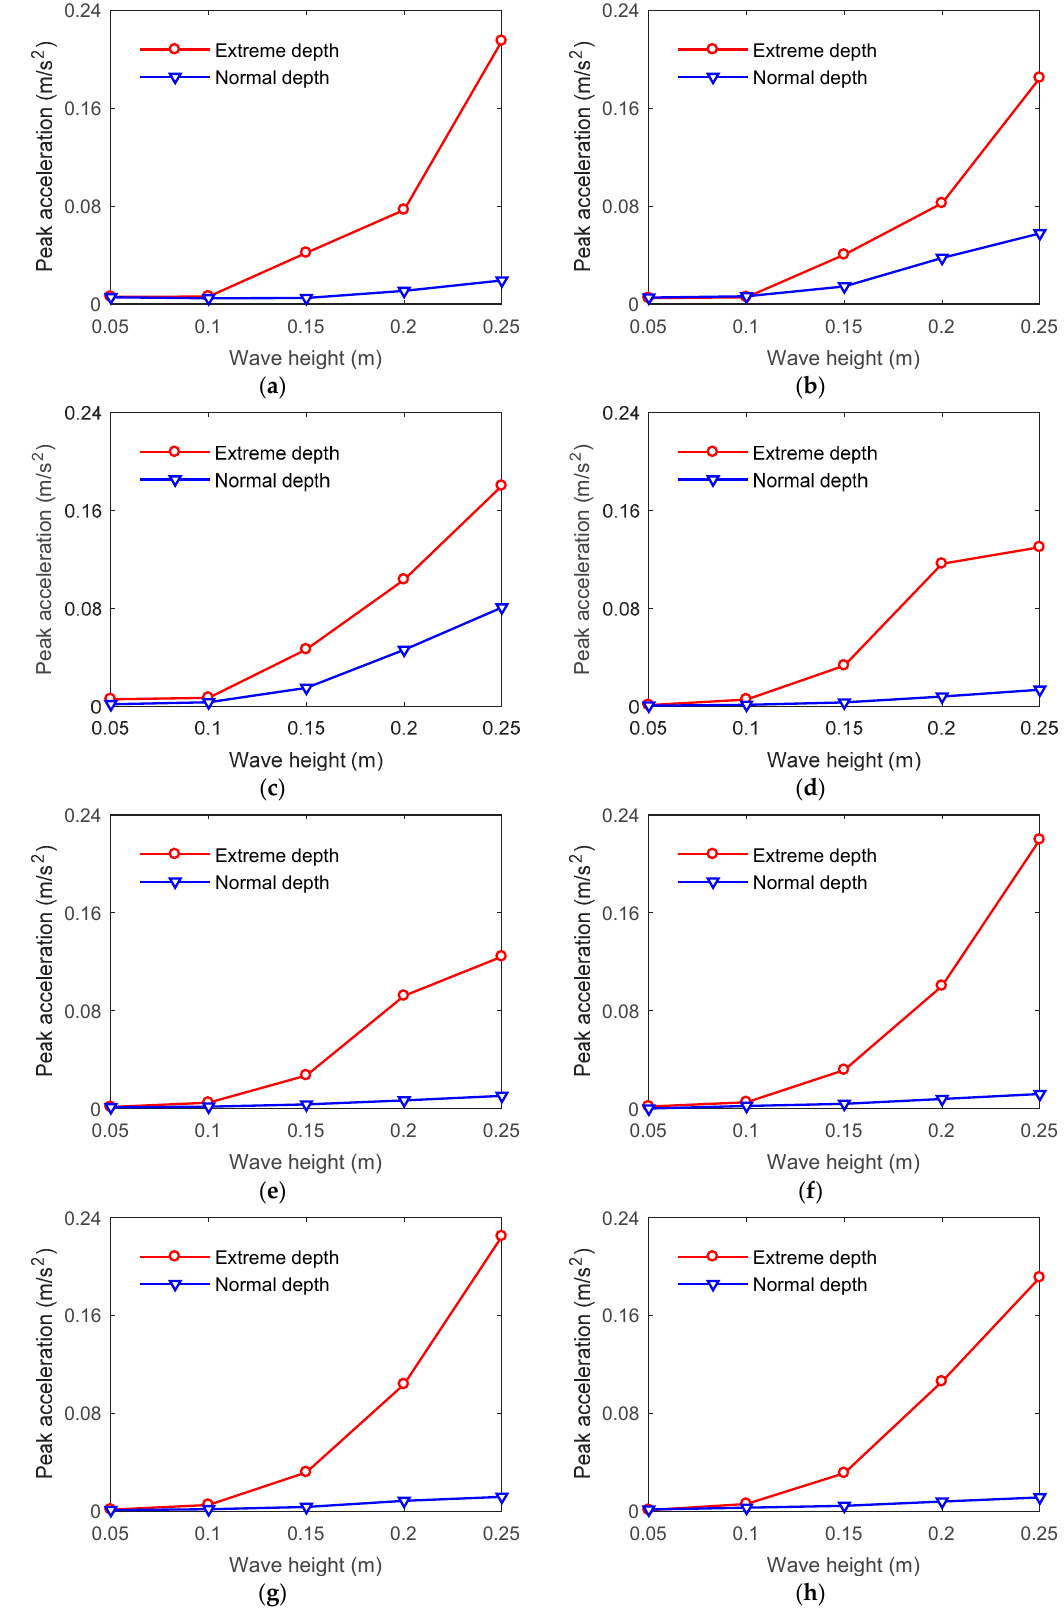
Figure 18. Structural peak accelerations at various measurement positions of the electrical platform with di ff erent water depths in waves for wave period of 1.6 s at attack angle of 90 ◦ . ( a ) J1; ( b ) J2; ( c ) J3; ( d ) J4; ( e ) J5; ( f ) J6; ( g ) J7; ( h )